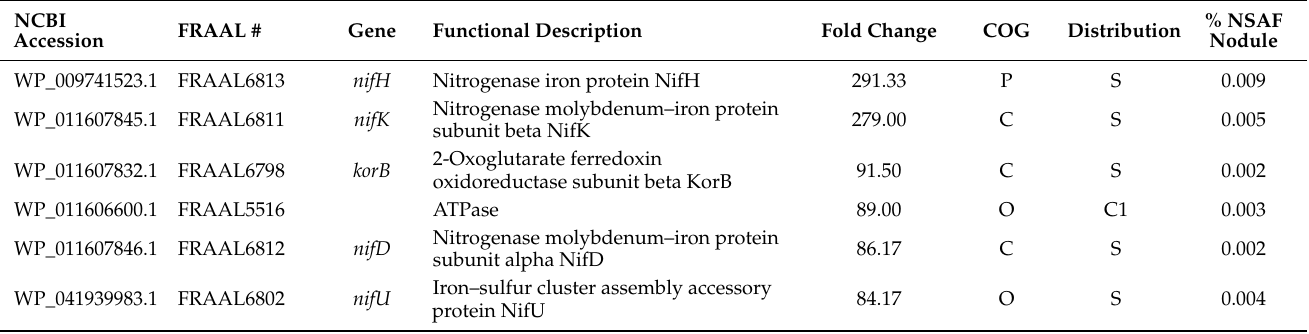
Table 1. List of the 100 most over-abundant Frankia proteins in nodules with the NCBI accession, the FRAAL Id, gene names, the protein name, the fold change, the COG (cluster of orthologous genes), the phylogenetic clusters distribution and the NSAF (normalized spectral abundance factors). The COGs are according to [30]. The distribution code A is present in all Frankia and in other actinomycetes, F is present in all Frankia strains, f is present in some Frankia strains and S is present in symbiotic Frankia strains (C1, C1c, C2 and C3 but not in C4). C1, C1c, C2, C3 and C4 indicate it is present in this cluster based on a threshold of 35% Id as seen on Mage [31]. Hypothetical genes have been removed from the list; they are listed in Table